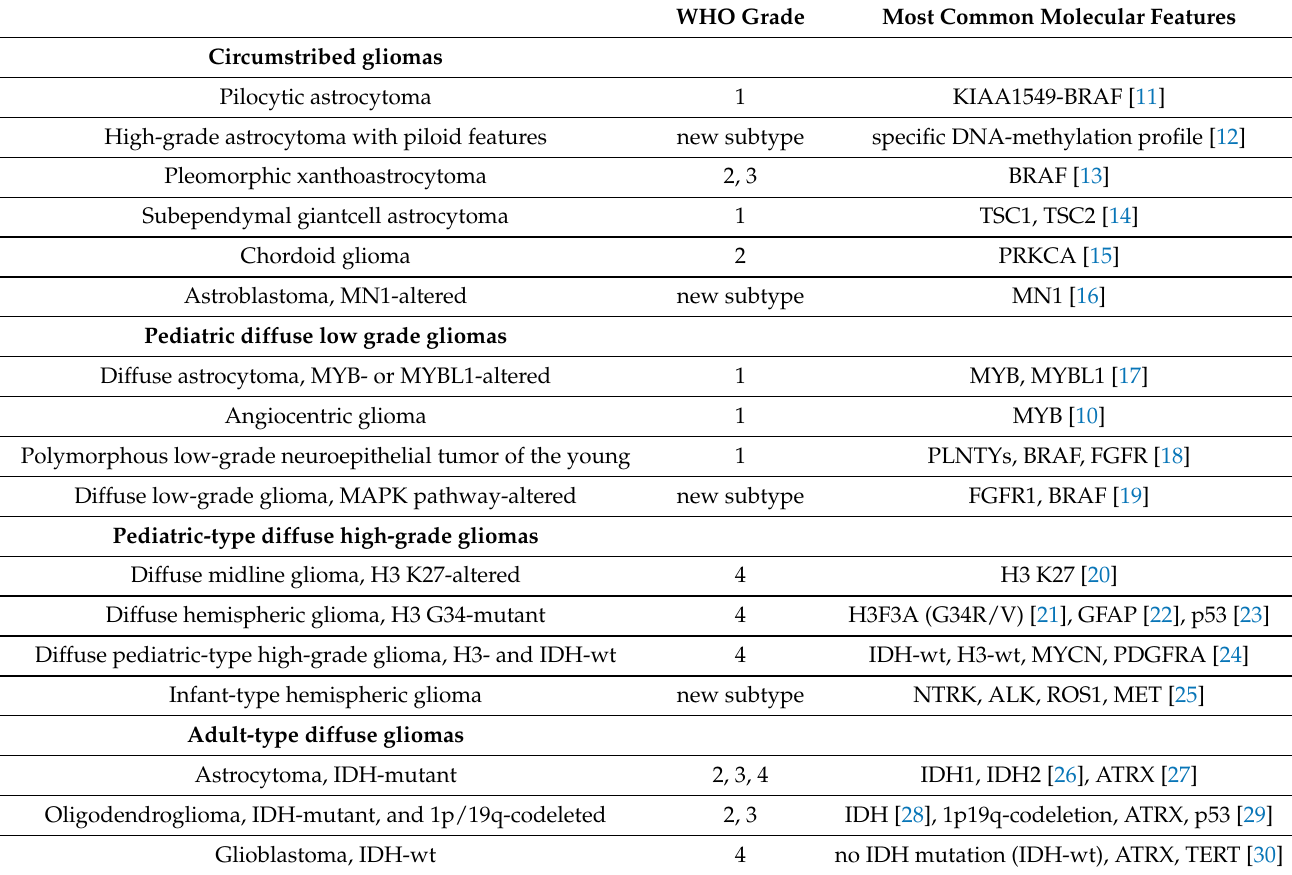
Table 1. Classification of gliomas according to the new 2021 WHO Classification [10]. The abbrevia- tions are given in the Abbreviations